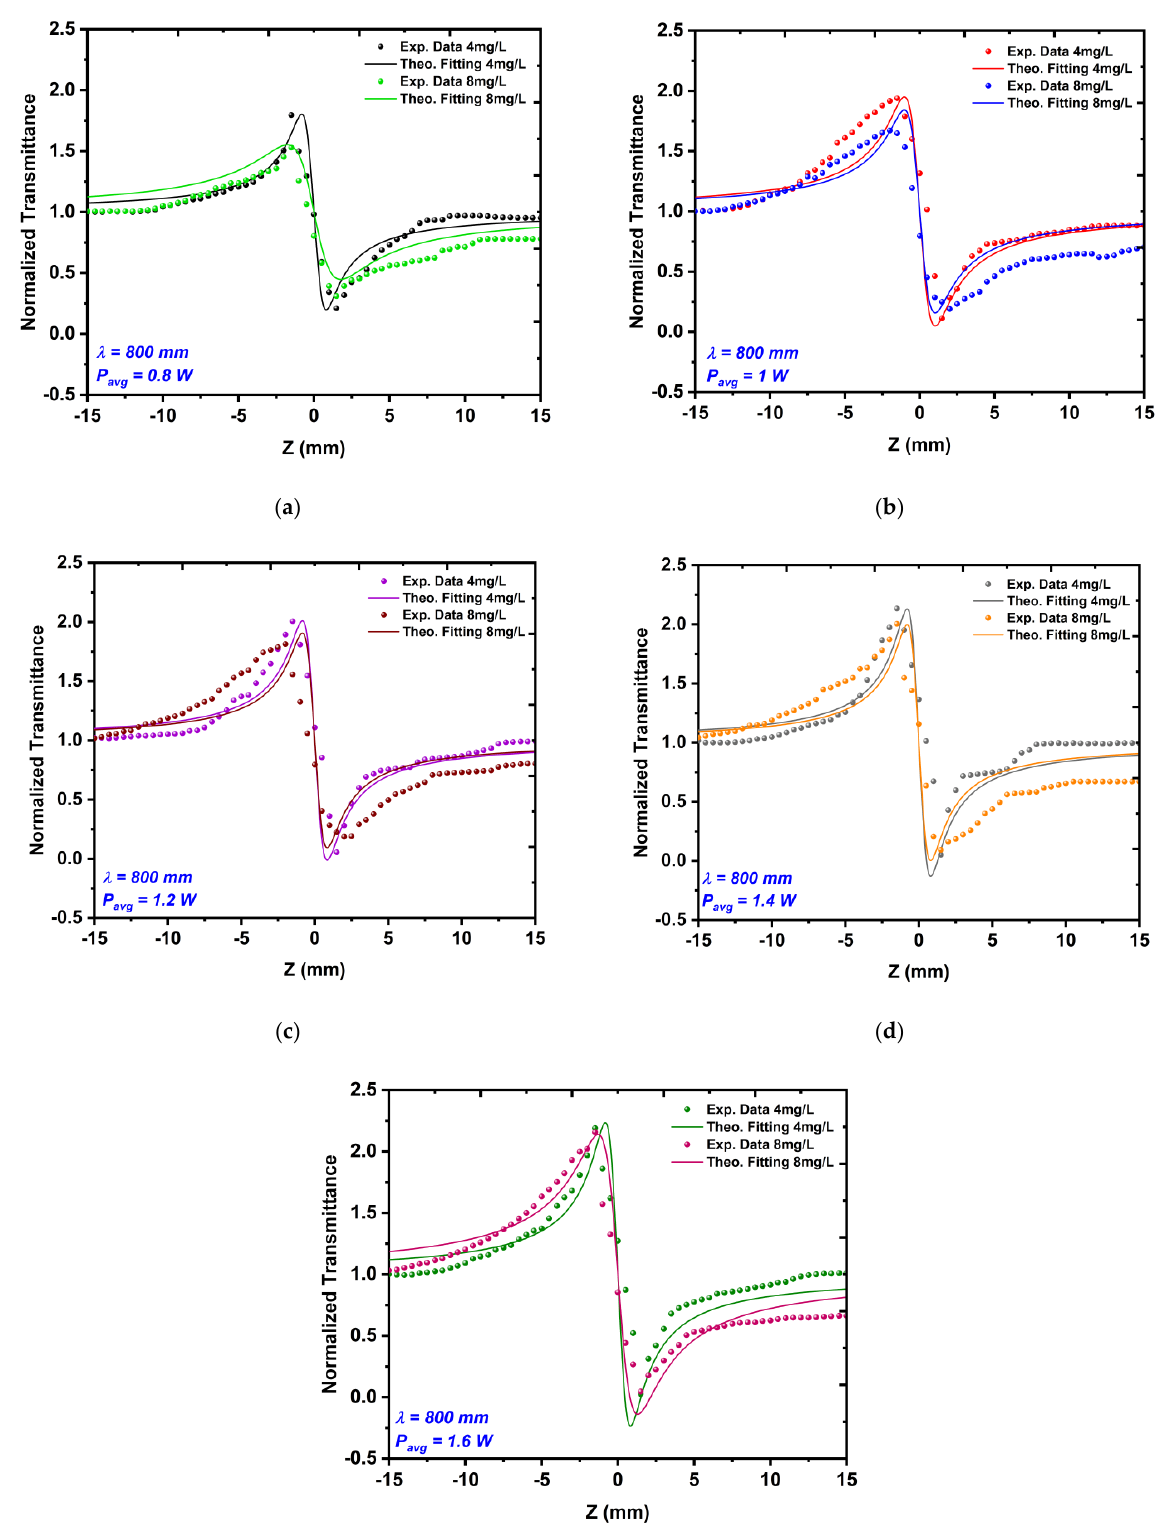
Figure 11. The CA z-scan measurements of the Au NP sample with a concentration of 4 mg/L for different average powers that ranged from 0.8 to 1.6 W ( a – e ) at a constant excitation wavelength of 800